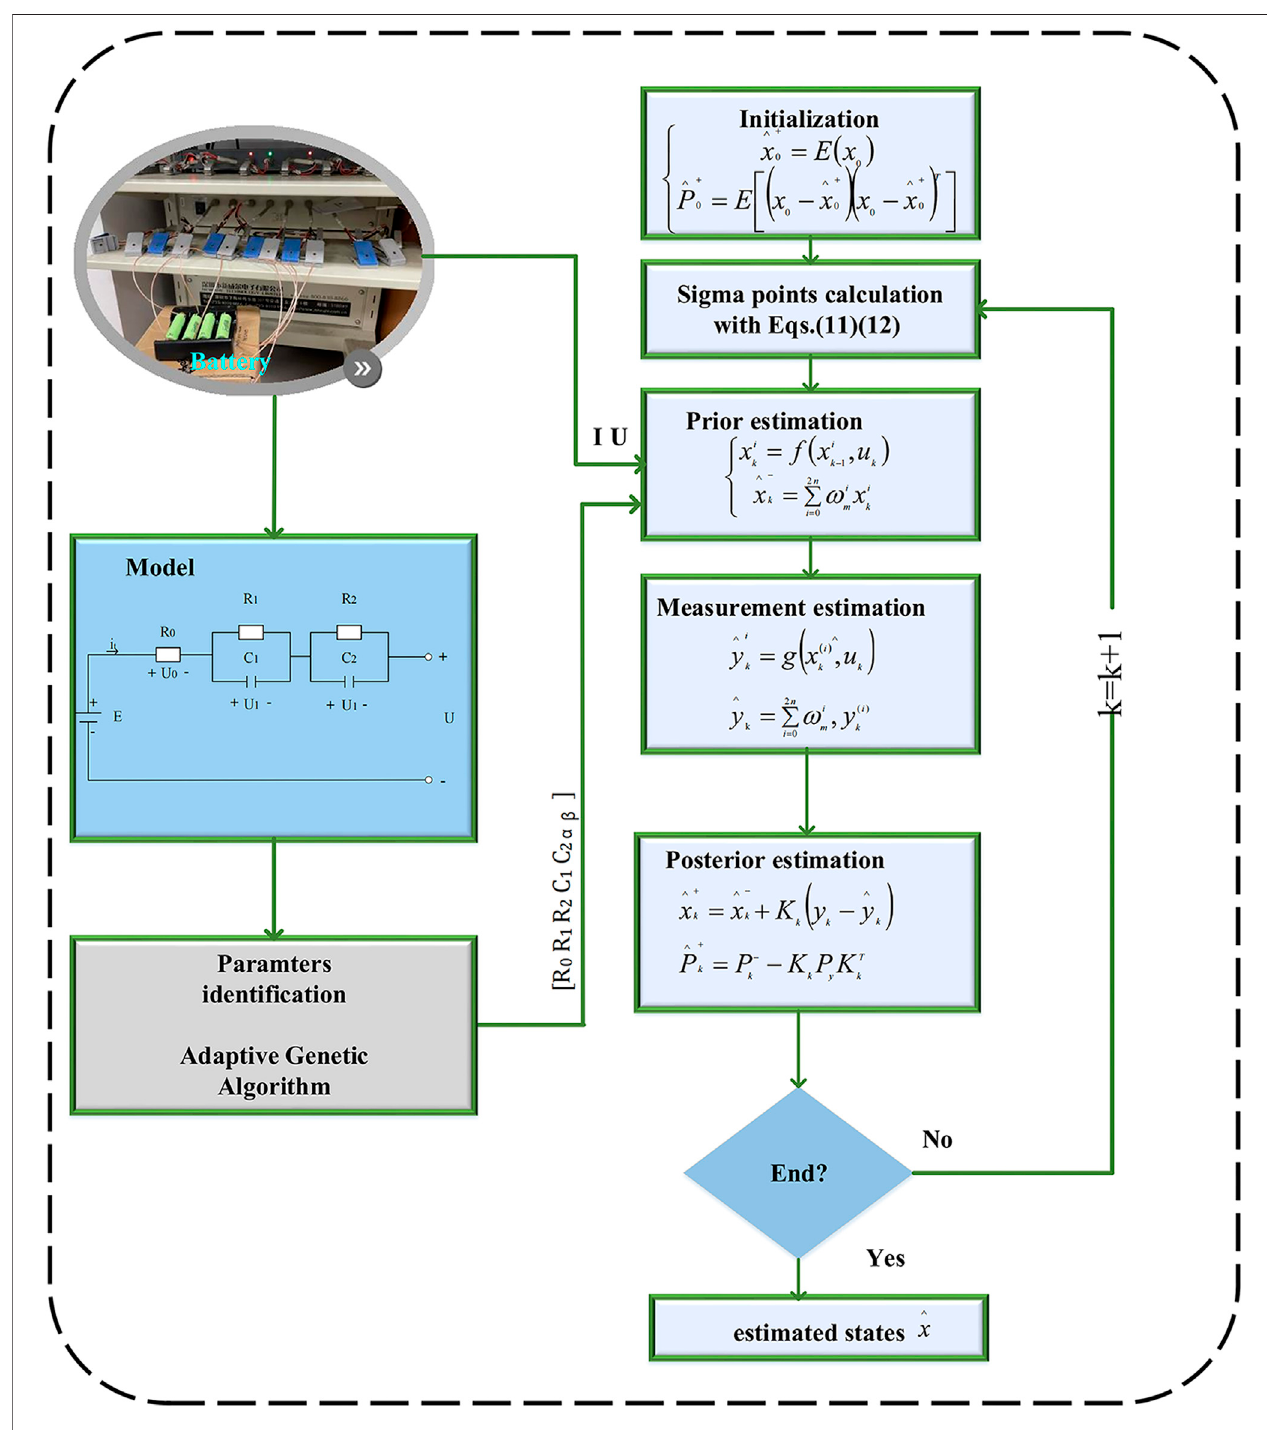
FIGURE 2 | Flowchart of the entire